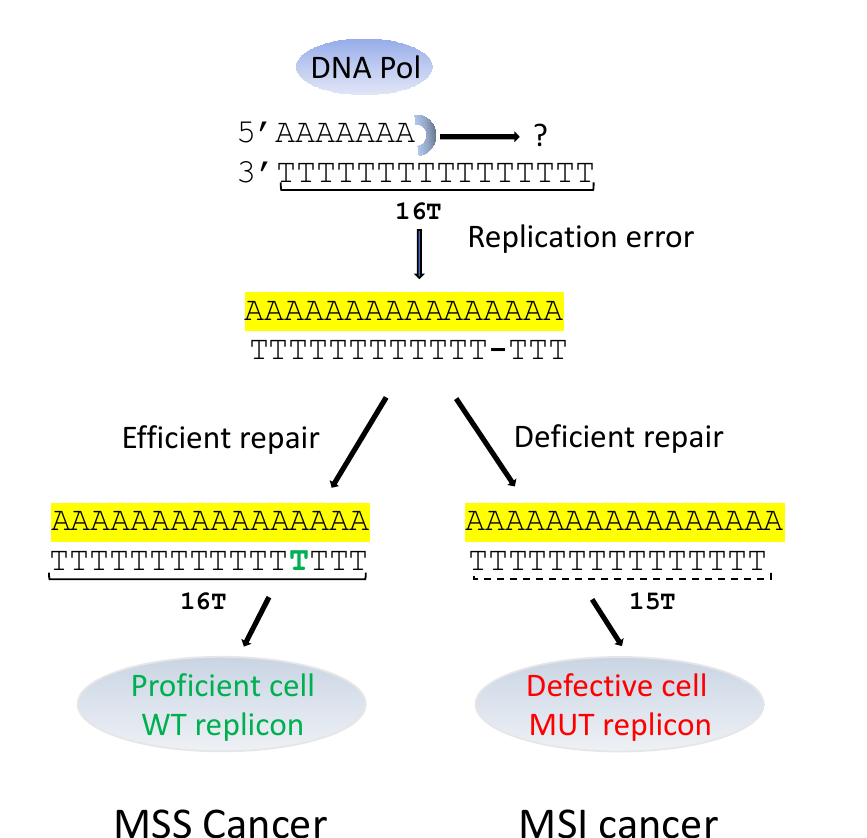
Figure 2. MSS and MSI splicing in cases of DNA replication errors. WT: Wild Type; MUT: Mutant. DNA replication errors may be fixed (MSS cancer) or not fixed (MSI cancer).